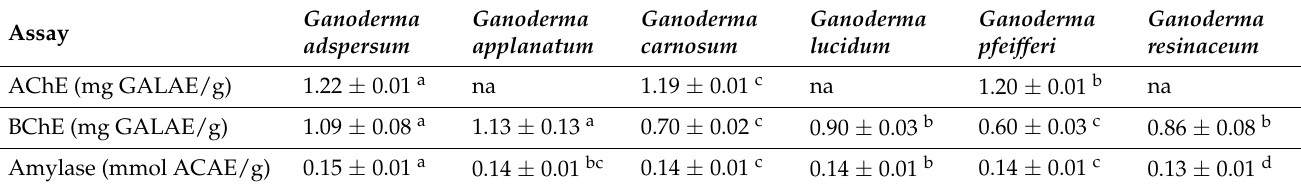
Table 3. Comparison of the inhibition of selected enzymes by biomass extracts